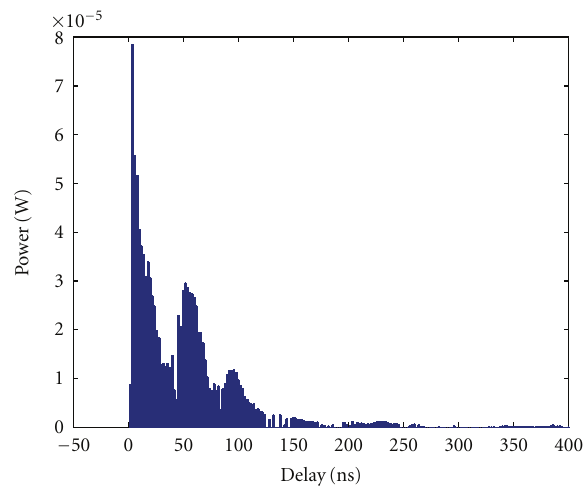
Figure 7: An example of a measured delay power profile, showing distinct